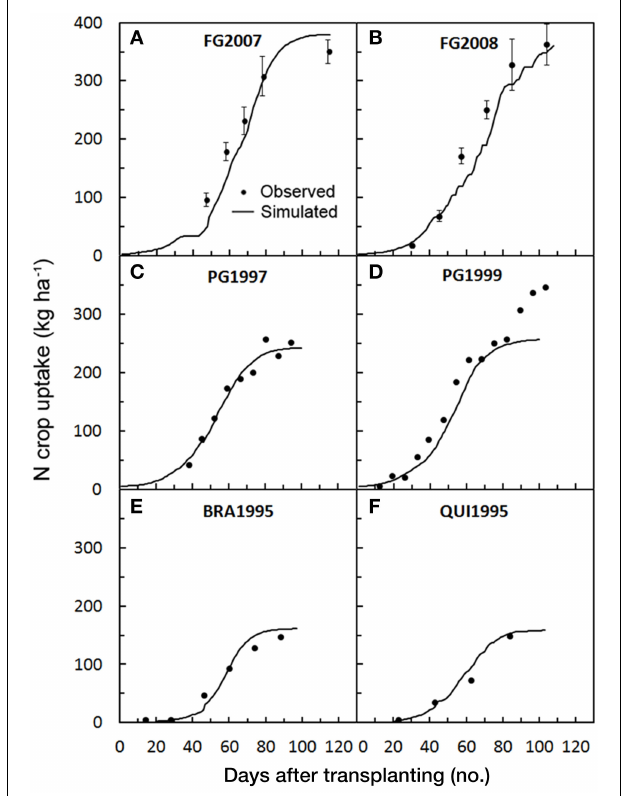
FIGURE 7 | Simulated and observed N crop uptake during the tomato cycles in Foggia (A: FG2007; B: FG2008), in Perugia (C: PG1997; D: PG1999) and in Florida (E: BRA1995; F: QUI1995), used for validating GesCoN . When available, mean standard errors are represented by vertical bars. (PG1997 and PG1999 re-elaborated from Tei et al., 2002; Onofri et al., 2009; BRA1995 and QUI1995 re-elaborated from Scholberg et al., 2000a,b).